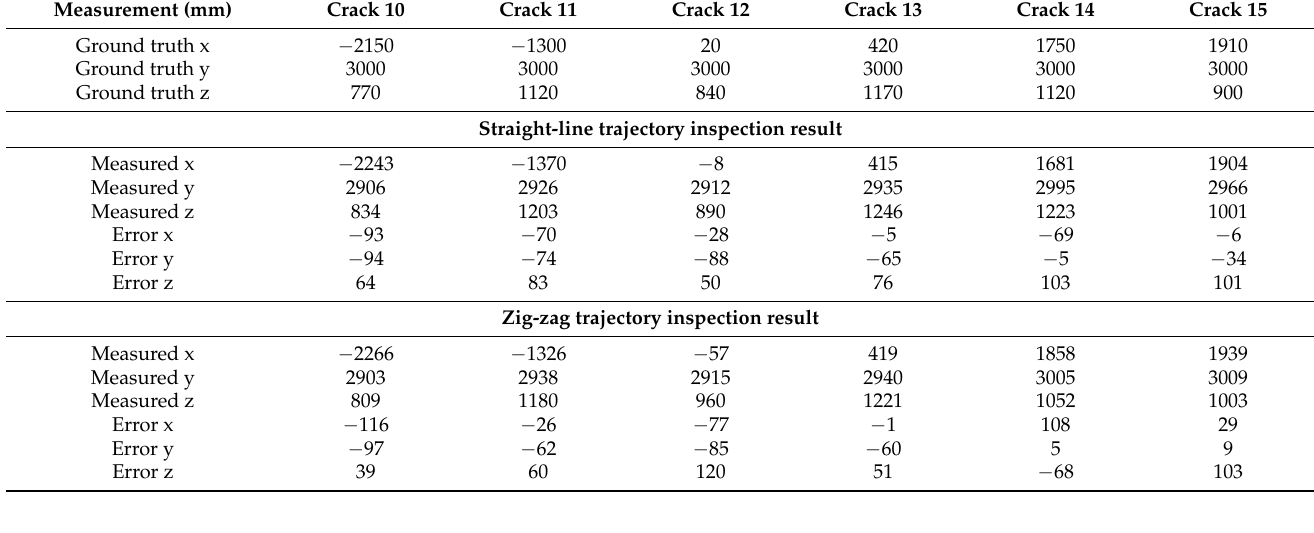
Table 7. The comparison between ground truth positions and measured positions on unseen cracks.